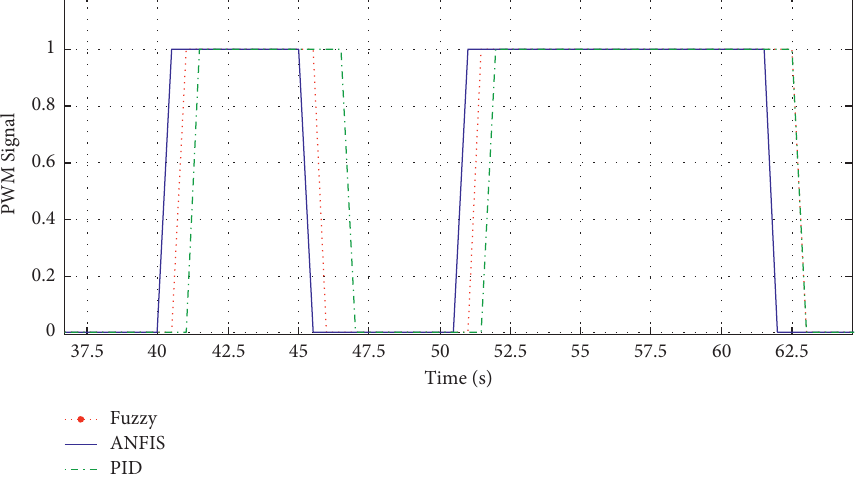
Figure 19: Zoom part of Figure